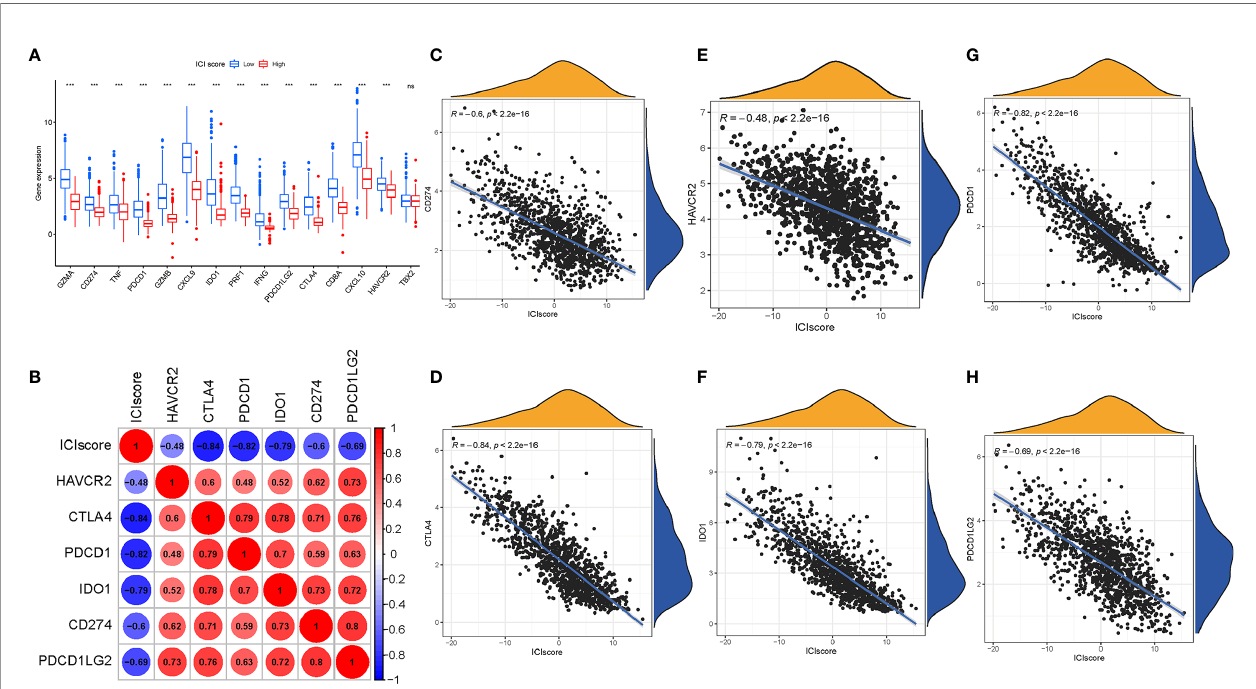
FIGURE 8 | Immunotherapeutic Signi fi cance of ICI Scores. (A) ICB-relevant genes (CD274, CTLA4, HAVCR2, IDO1, PDCD1, and PDCD1LG2) and in fl ammatory- related genes (CD8A, CXCL10, CXCL9, GZMA, GZMB, IFNG, PRF1, TBX2, and TNF) expressed in the high and low ICI score subgroups. Correlation between the ICI score with crucial immune checkpoint blockade genes. (B) Correlation analysis between immune checkpoint inhibitors (CD274, PDCD1, PDCD1LG2, CTLA4, HAVCR2, and IDO1) with the ICI score. (C) Correlation between the ICI score and CD274. (D) Correlation between the ICI score and CTLA4. (E) Correlation between the ICI score and HAVCR2. (F) Correlation between the ICI score and IDO1. (G) Correlation between the ICI score and PDCD1. (H) Correlation between the ICI score and PDCD1LG2. The asterisks represented the statistical p value (***P < 0.001), ns, No Signi fi